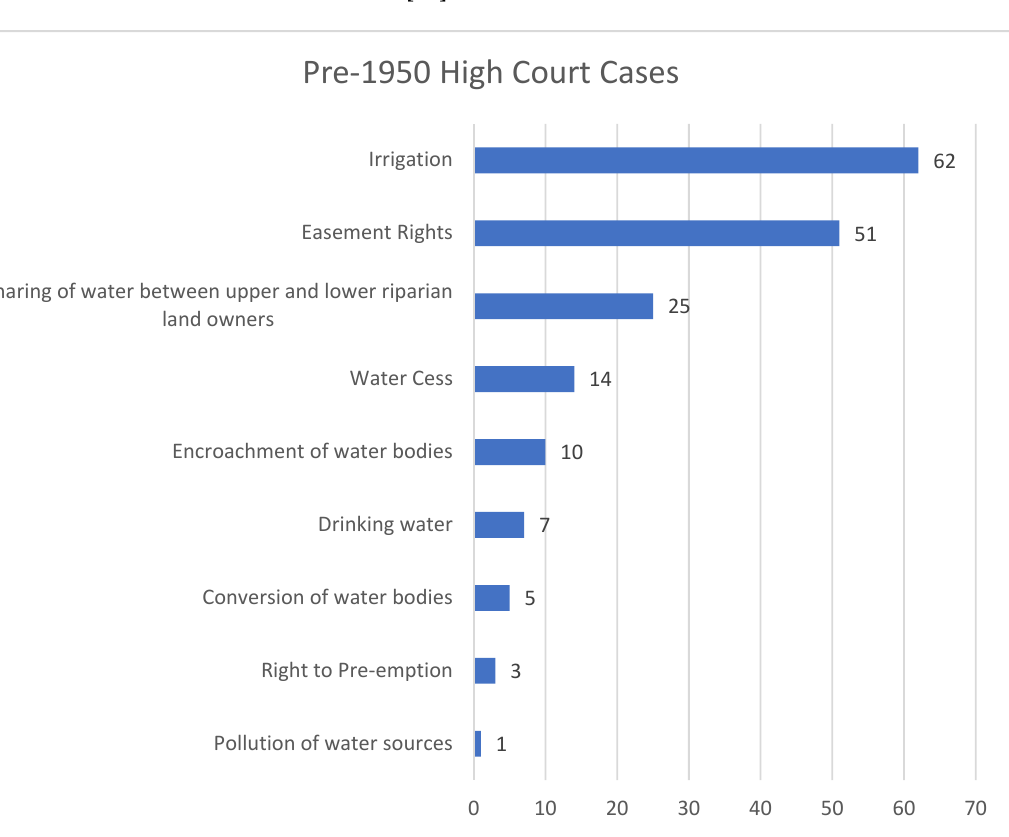
Figure 4. Overlapping distribution of claims decided by High Courts pre-1950 .